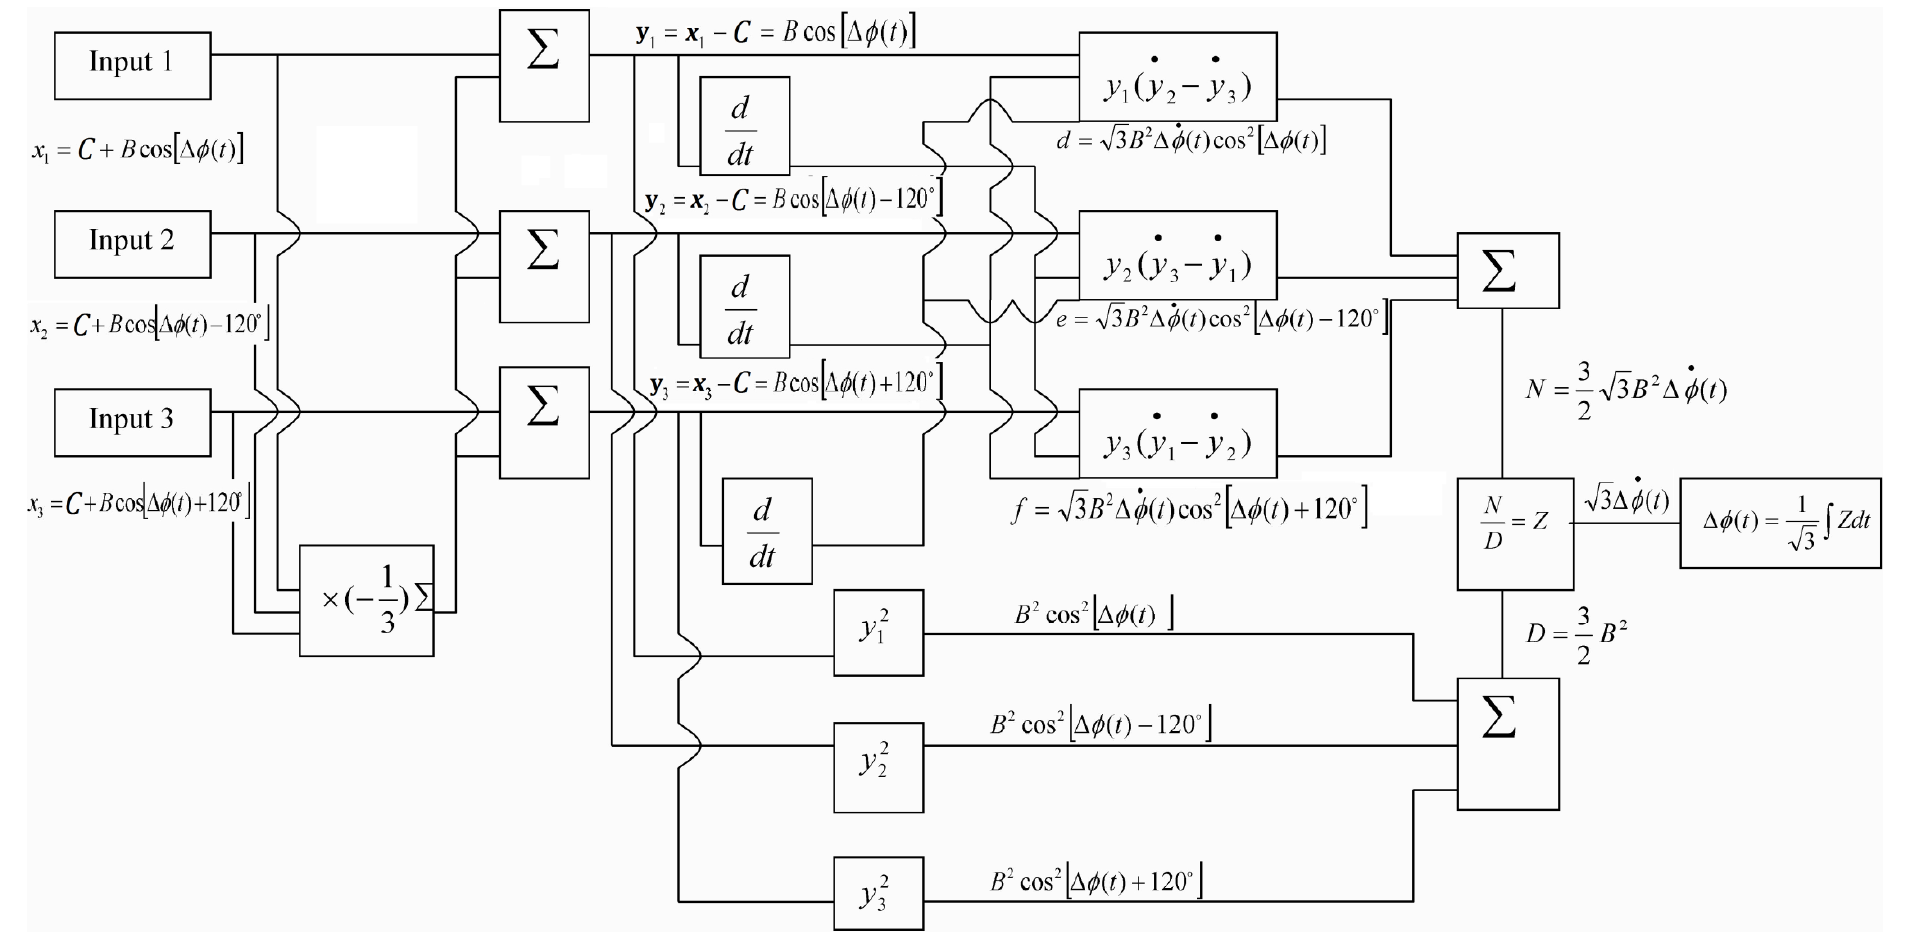
Figure 3. Block diagram of the phase shift